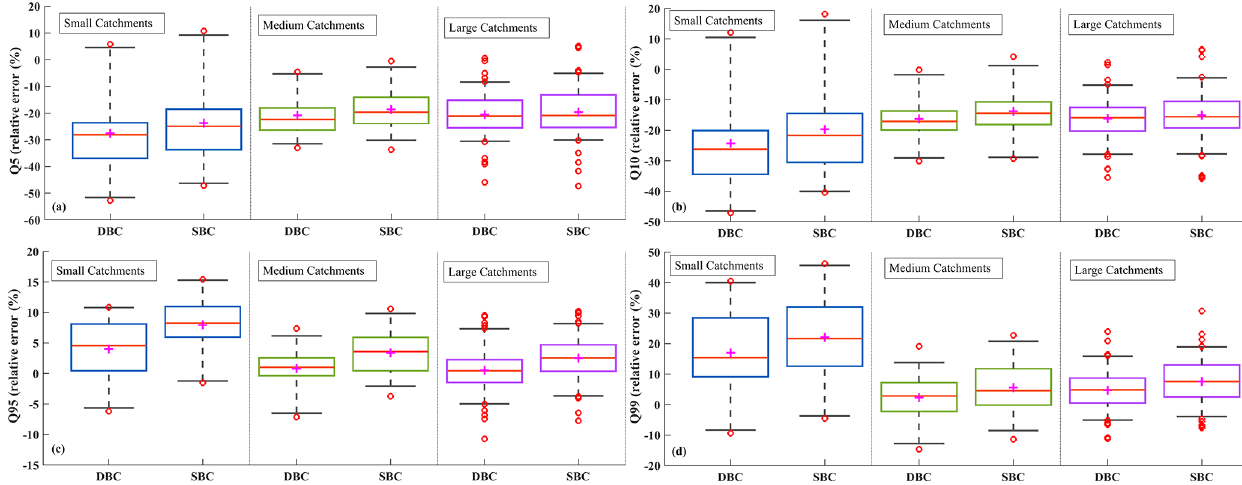
Figure 8. Distribution of the relative error ((model-obs) / obs × 100%) corresponding to flow quantiles Q 5 (a) , Q 10 (b) , Q 95 (c) , and Q 99 (d) . Boxplots for both bias-correction methods (DBC and SBC) are constructed from the distribution of relative errors from all catch- ments within each size class (small, medium, and